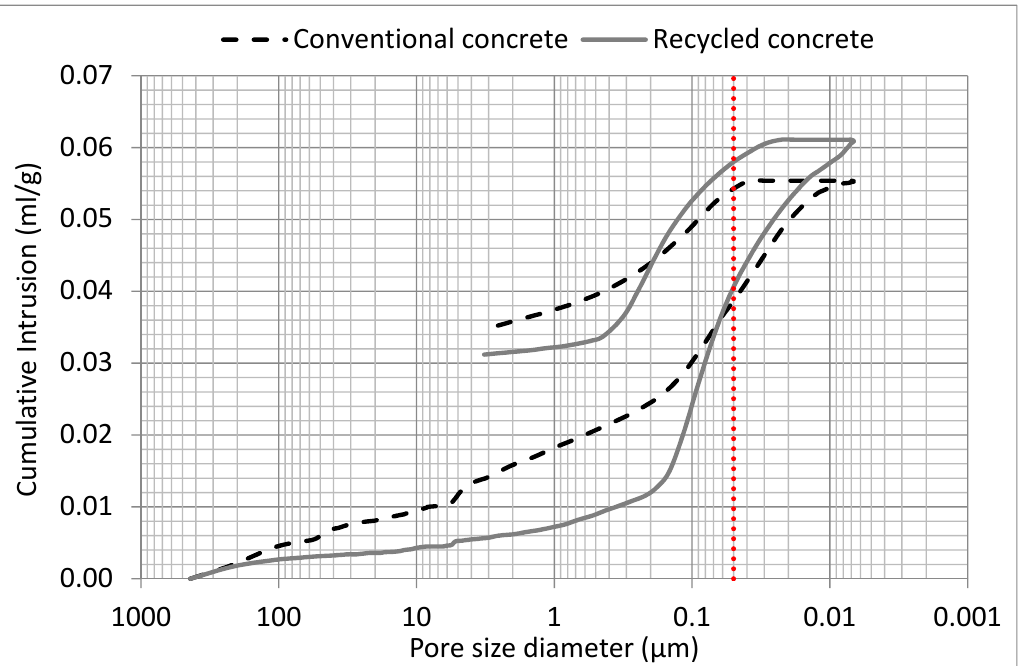
Figure 10. Pore size distribution of conventional and recycled concrete sample at 28 days.